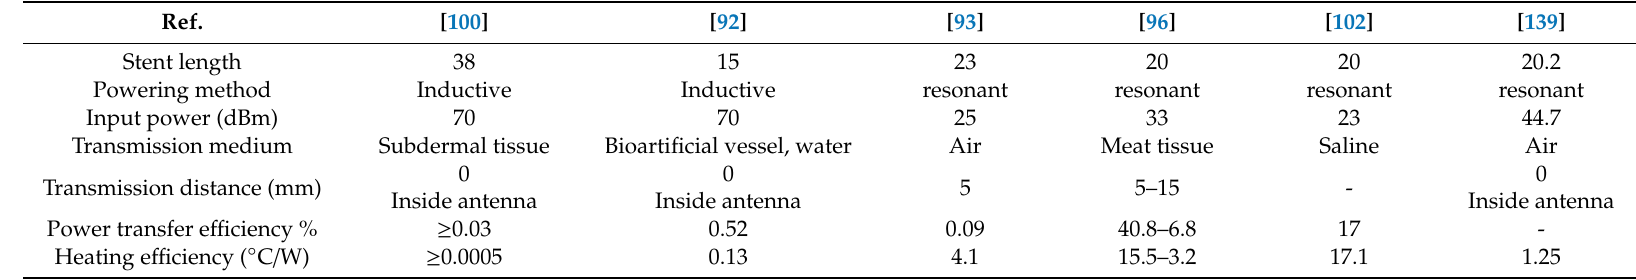
Table A2. This is a table show the design performance for hyperthermia treatment was done by researcher. Reproduced with permission [96], Copyright 2020, IEEE.